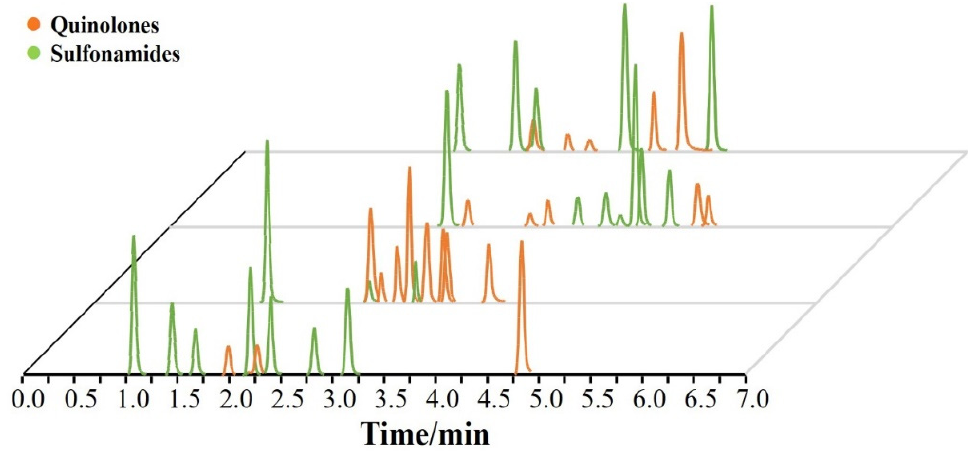
Figure 1. Extracted ion chromatograms of antimicrobial drugs obtained from the spiked sample at 50 μ g/kg.